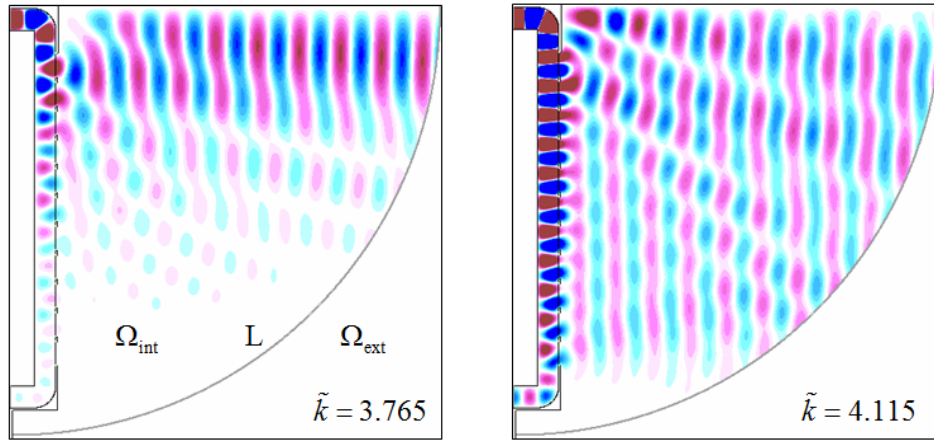
TE -wave with 01 ( ) , E g t φ in the